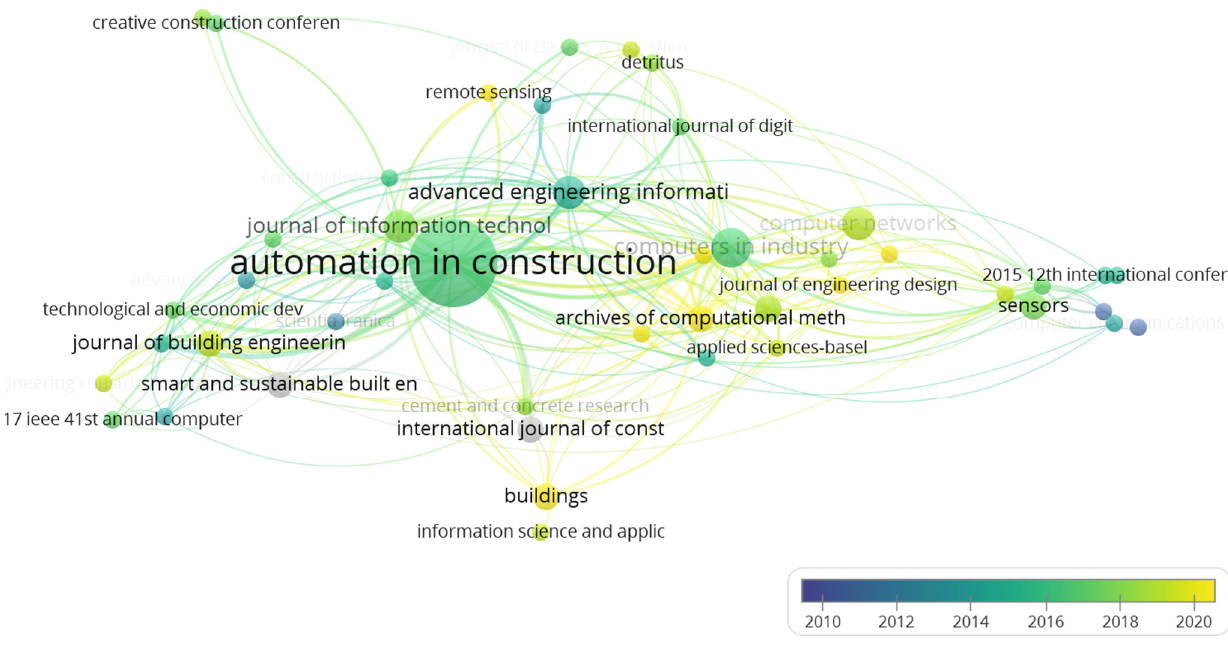
Figure 3. Network map of referenced journal clusters.